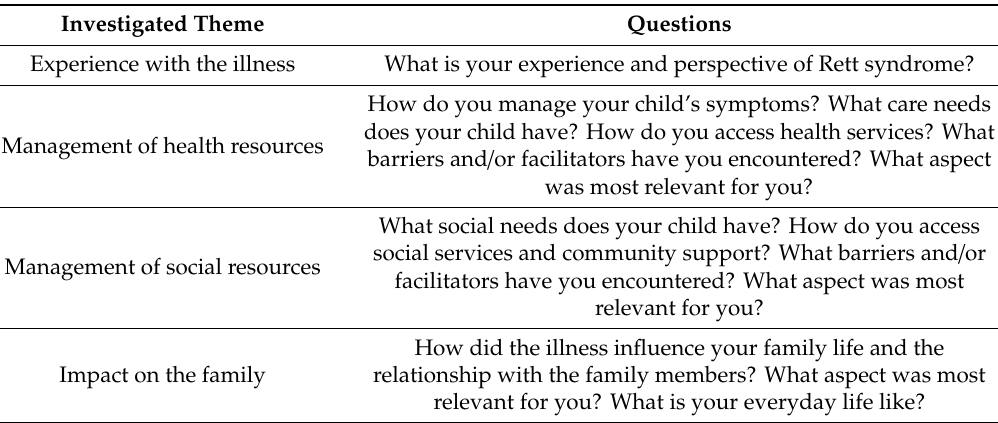
Table 2. Questions